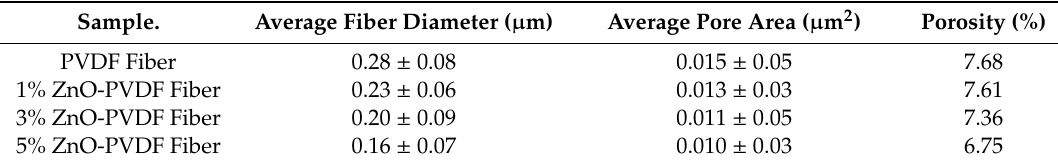
Table 1. Fiber diameter and